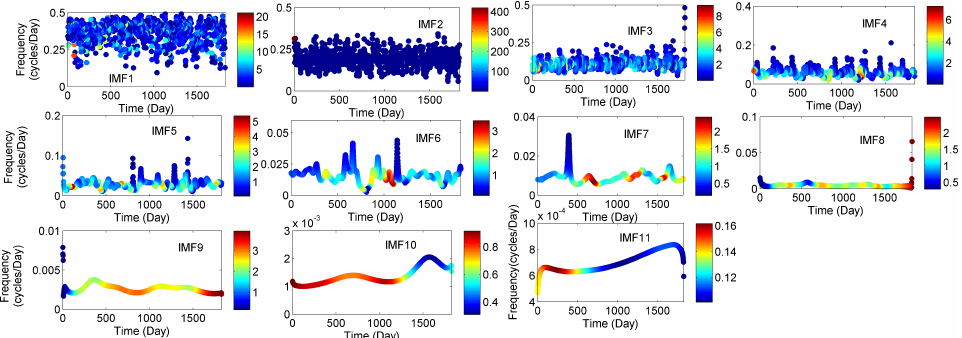
Figure 6. The time-frequency-amplitude spectra of the IMFs of temperature.